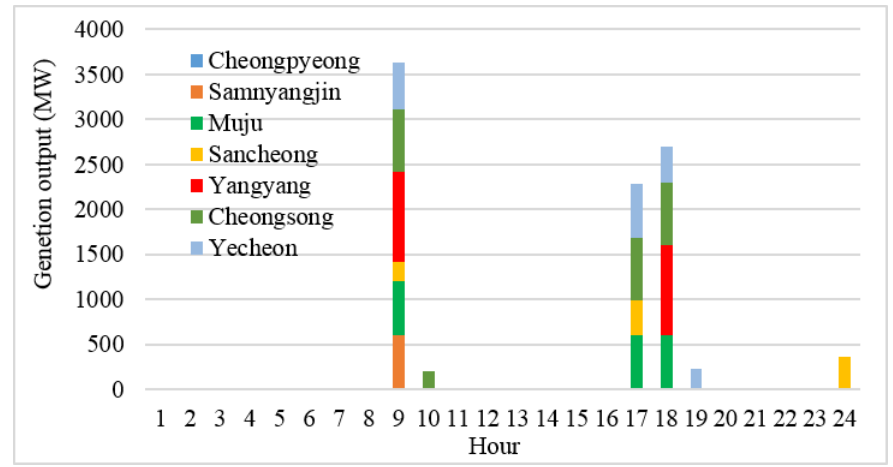
Table 6. EP i and P i,t − Δ t on the peak-load day in 2029.